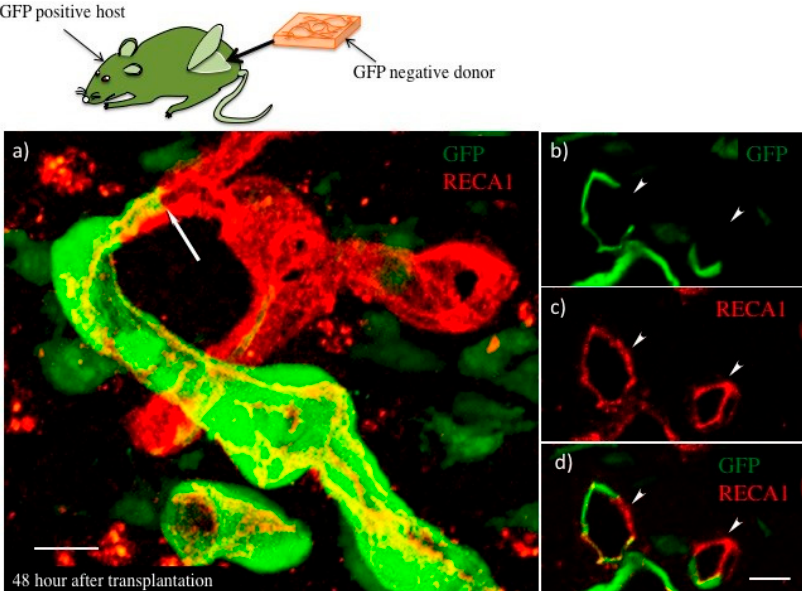
Figure 4. Donor myocardial cell sheets transplanted into GFP+ host rats. ( a ) Host–donor vasculature connecting point shown by confocal microscopy. Green indicates GFP+ cells, and red indicates RECA-1+ ECs. Arrow indicates host–donor EC connecting border. ( b – d ) show the section of connecting points. ( b ) GFP+ host originated vascular image and ( c ) RECA-1+ total vascular image. ( d ) A merged image of ( b ) and ( c ). Arrow-heads indicate GFP-vasculature originating from donor. Scale bar: ( a , d ), about 10µm. The scale bar was added with estimation from original data.